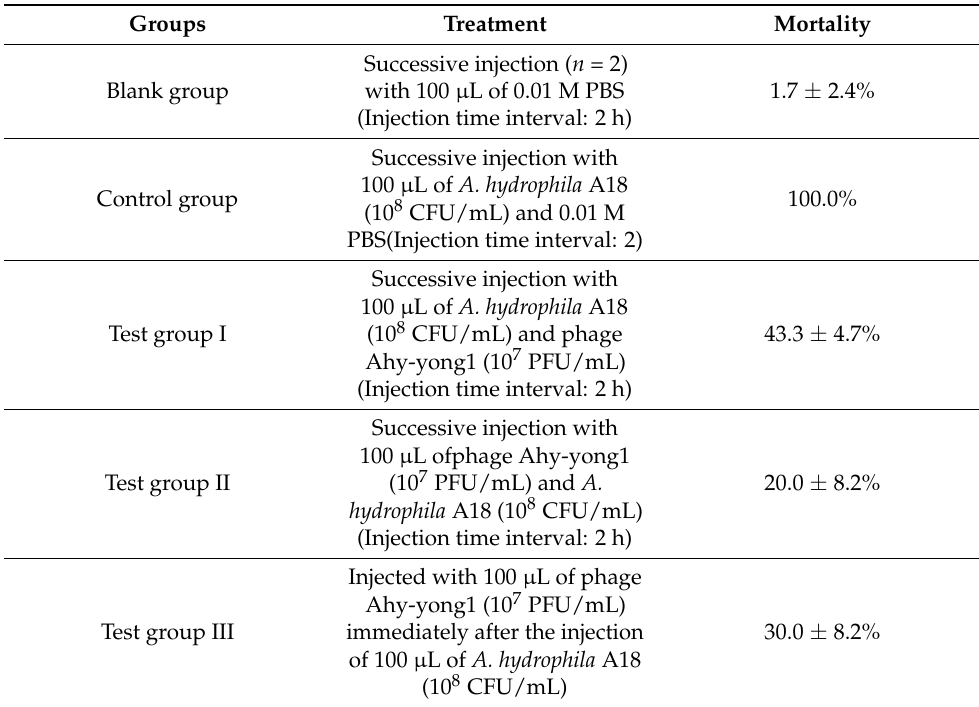
Table 2. Treatment and cumulative mortality of brocade carps of the five groups in the protective